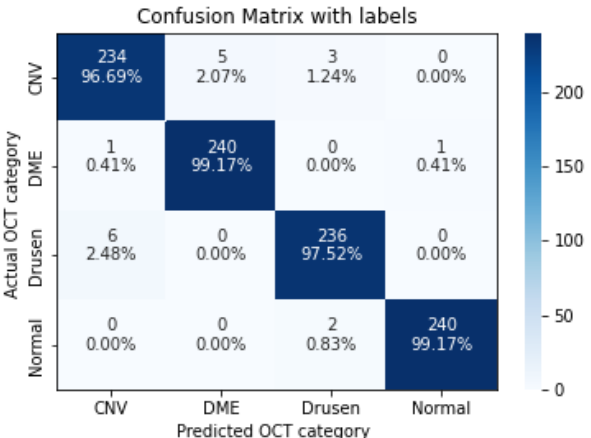
Figure 8. The confusion matrix of 7 layers model, with numbers and percentages.